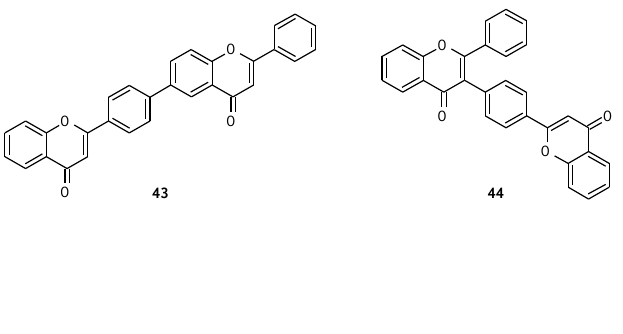
Figure 4. Structures of two unsubstituted